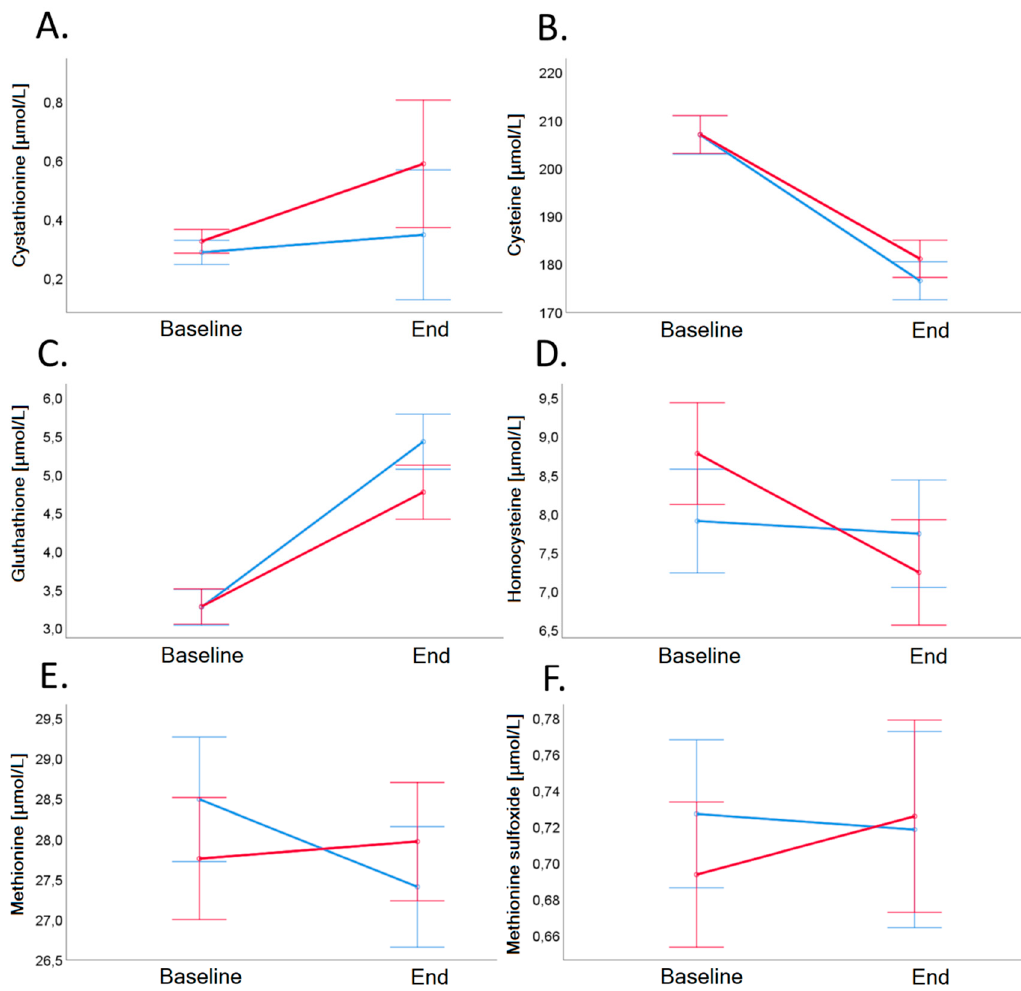
Figure 4. Relationship of serum holotranscobalamin and vitamin B 12 in the two randomized groups after a 4-week dietary intervention. Vitamin B 12 (ng/L) correlates positively with holotranscobalamin concentration (pmol/L) both after intervention in VD (Panel A , r = 0.695, p < 0.001) and in MD (Panel B , r = 0.484, p = 0.010). Dispersion lines show the 95% confidence interval of the linear regression fit.